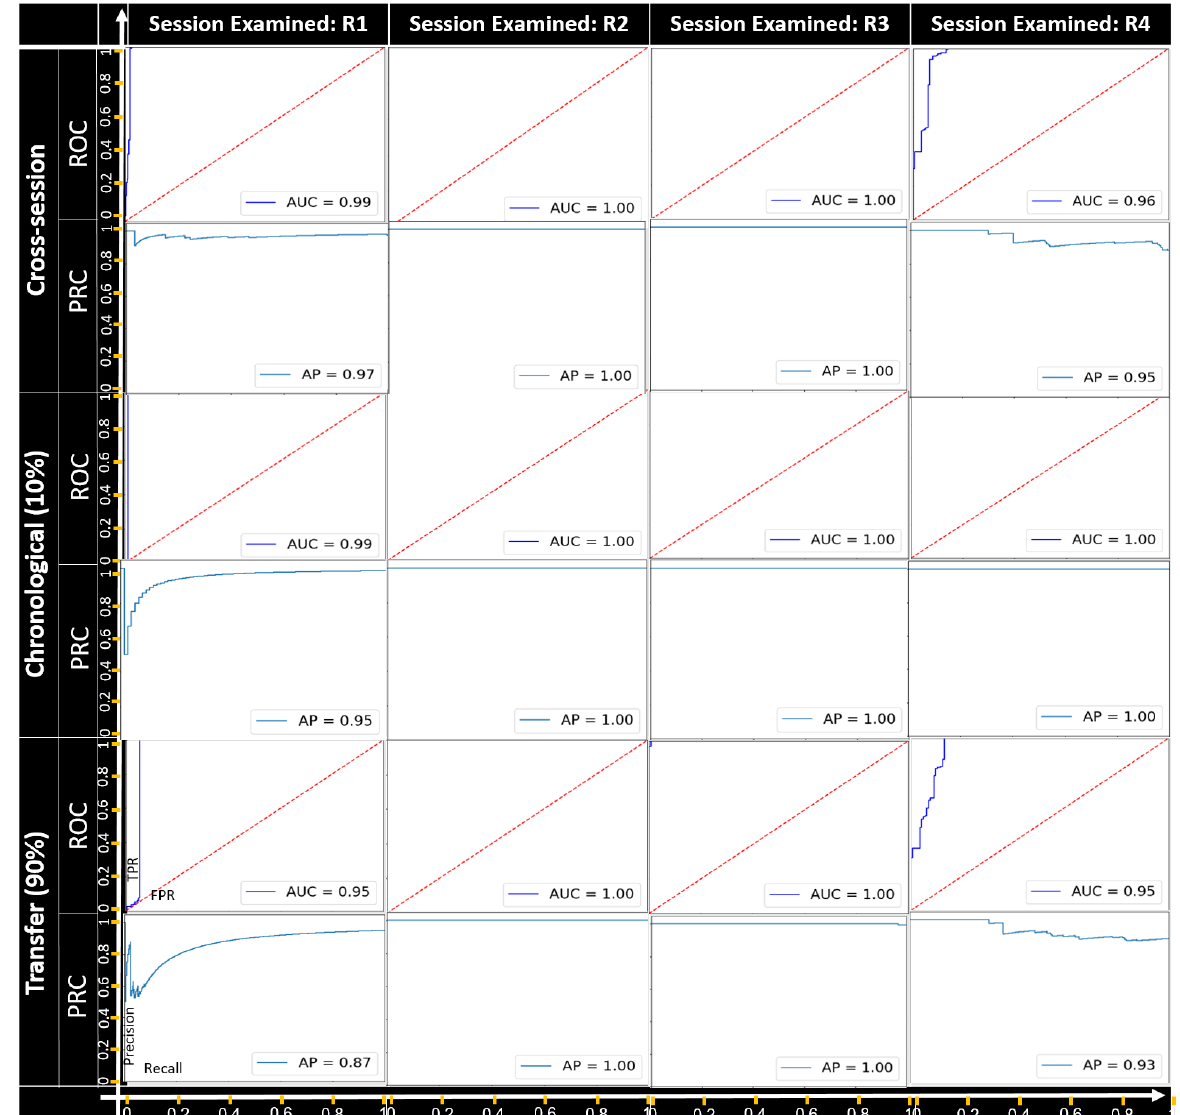
Figure 7. The ROC and PRC curves for the alertRaised feature-manipulation attack for each recording session